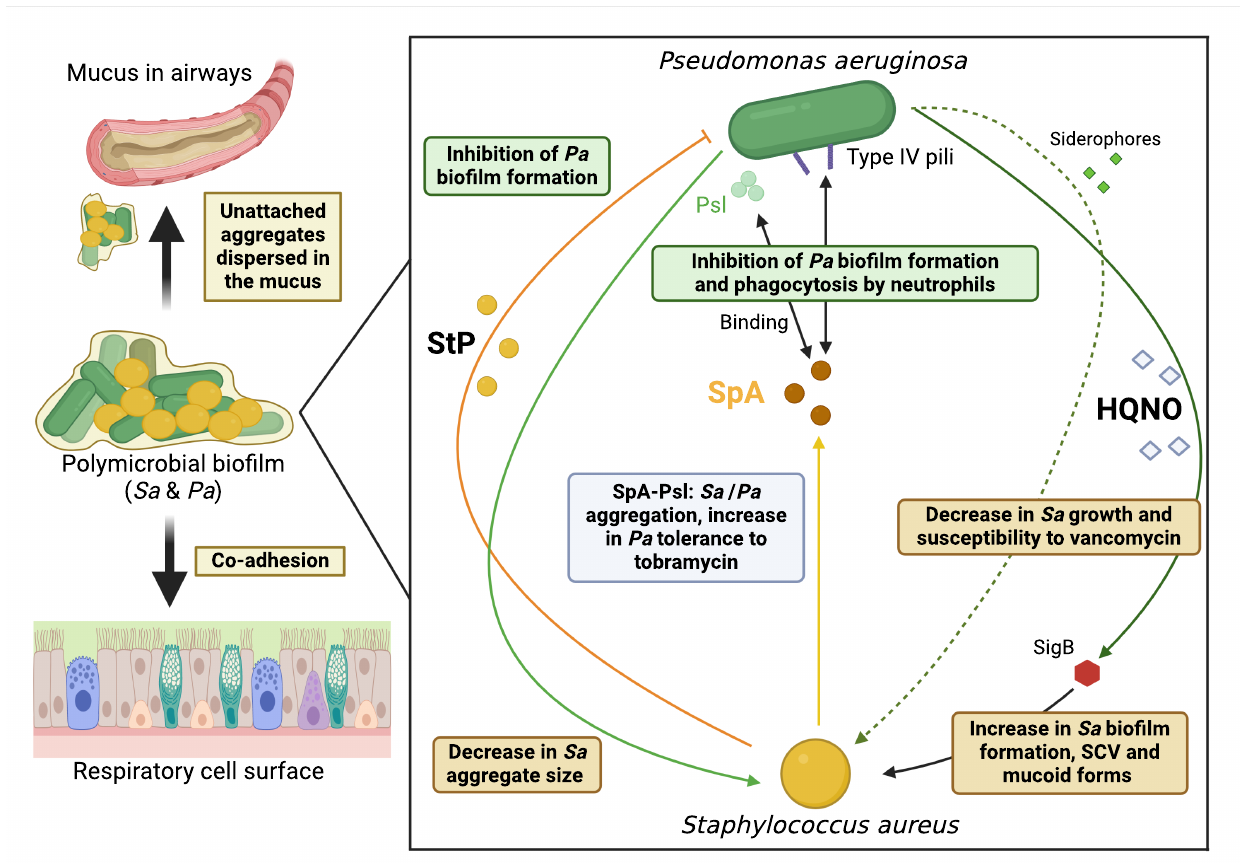
Figure 2. Diagram showing the major mechanisms involved in the interaction between CF Staphylococcus aureus ( Sa , in orange) and Pseudomonas aeruginosa ( Pa , in green) strains in dual-species biofilm. The text boxes specify the role associated with each molecule/mechanism. StP: Staphylopine; SpA: Staphylococcal protein A; HQNO: 2-heptyl-4-hydroxyquinoline N-oxide; Psl: Polysaccharide synthesis locus; SigB: Sigma Factor B; SVC: Small Colony Variant (figure created with Biorender.com (accessed on 31 October 2022)).